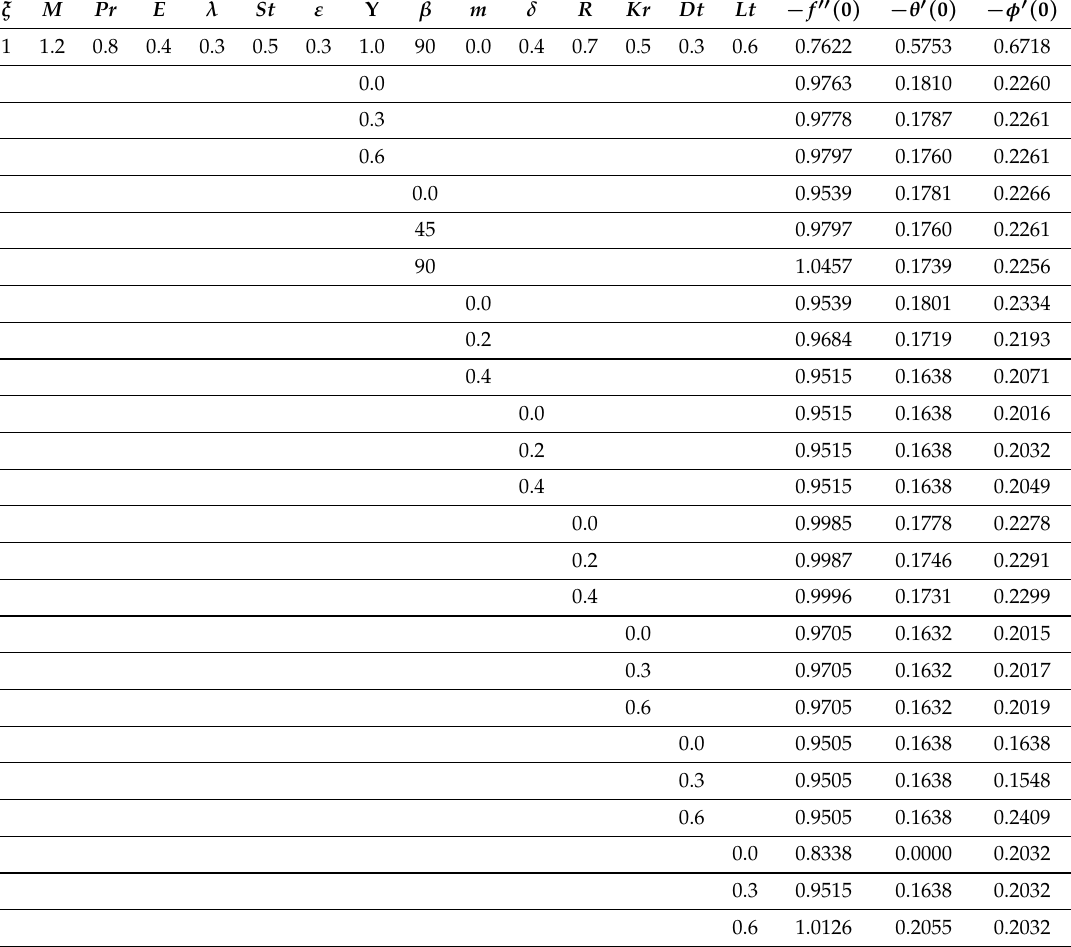
Table 3. Effects of A , M , Pr , λ , ε , Υ , δ , and β on − f (cid:48)(cid:48) ( 0 ) , − θ (cid:48) ( 0 ) and − φ (cid:48) ( 0 )